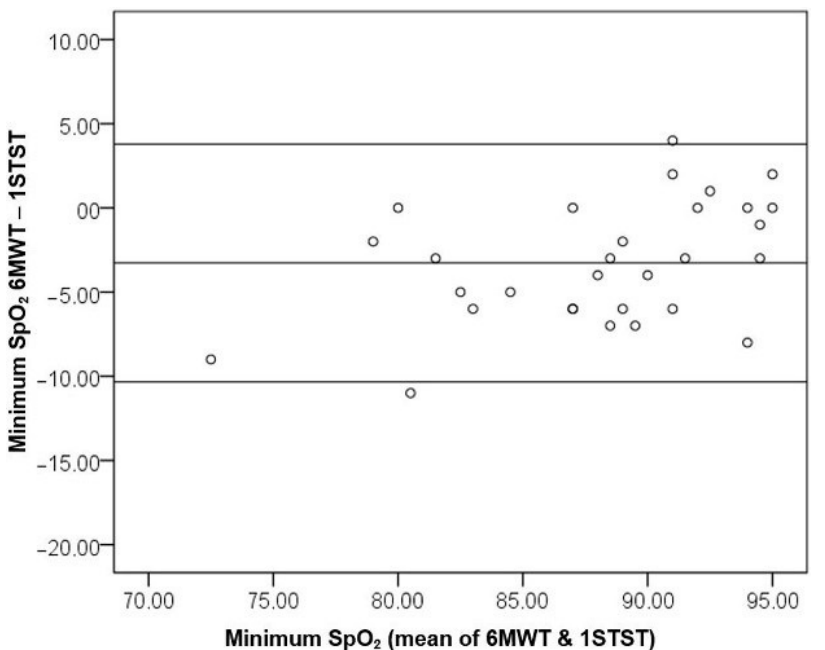
Figure 4. Bland–Altman plot of the difference in the minimum SpO 2 between the 6MWT and 1STST as a function of the mean minimum SpO 2 in both tests. (SpO 2 = oxygen saturation; 6MWT = 6-min walking test; 1STST = 1-min sit-to-stand test).